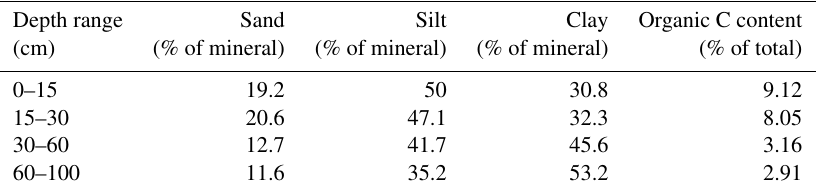
Figure 1. FR-Aur and FR-Lam ICOS stations (https://www.icos-cp.eu/, last access: 25 January 2023) and pit emplacements. Table 1. Pit A FR-Aur soil